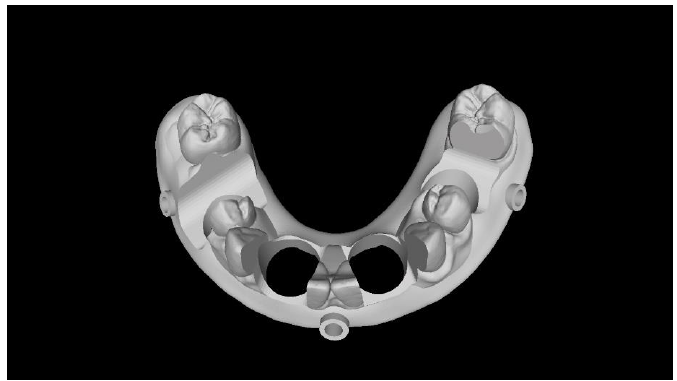
Figure 5. Computer-aided design of the prosthetic template for the four-implant impression.